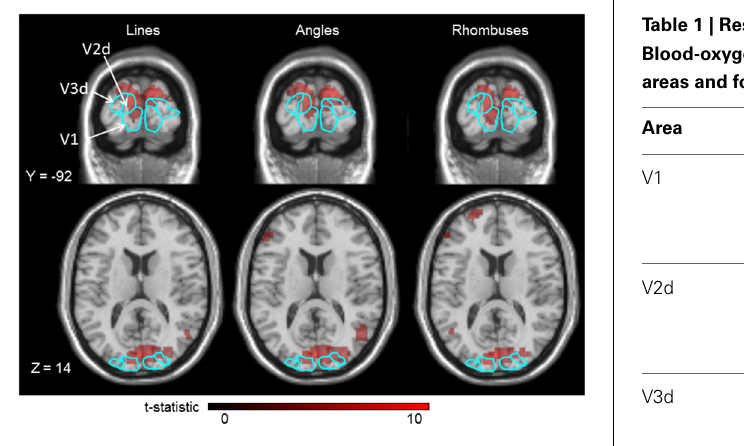
FIGURE 3 | Cortical activations produced in the three visual areas (V1–V3) by lines, angles, and rhombuses vs. baseline, for a typical single subject, superimposed on his anatomical brain image. Smoothing was not applied. Borders of those visual areas are displayed in light blue lines. Displayed threshold of P (FWE) < 0.05.